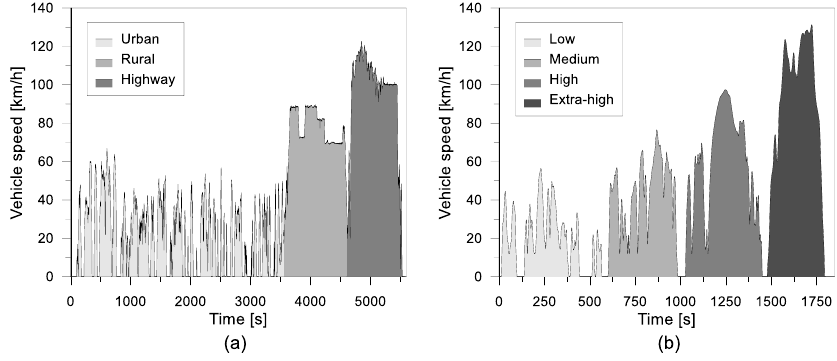
Figure 7. Time-vehicle speed profiles of the real driving emissions (RDE) ( a ) and worldwide harmonized light vehicles test cycle (WLTC) ( b ) cycles